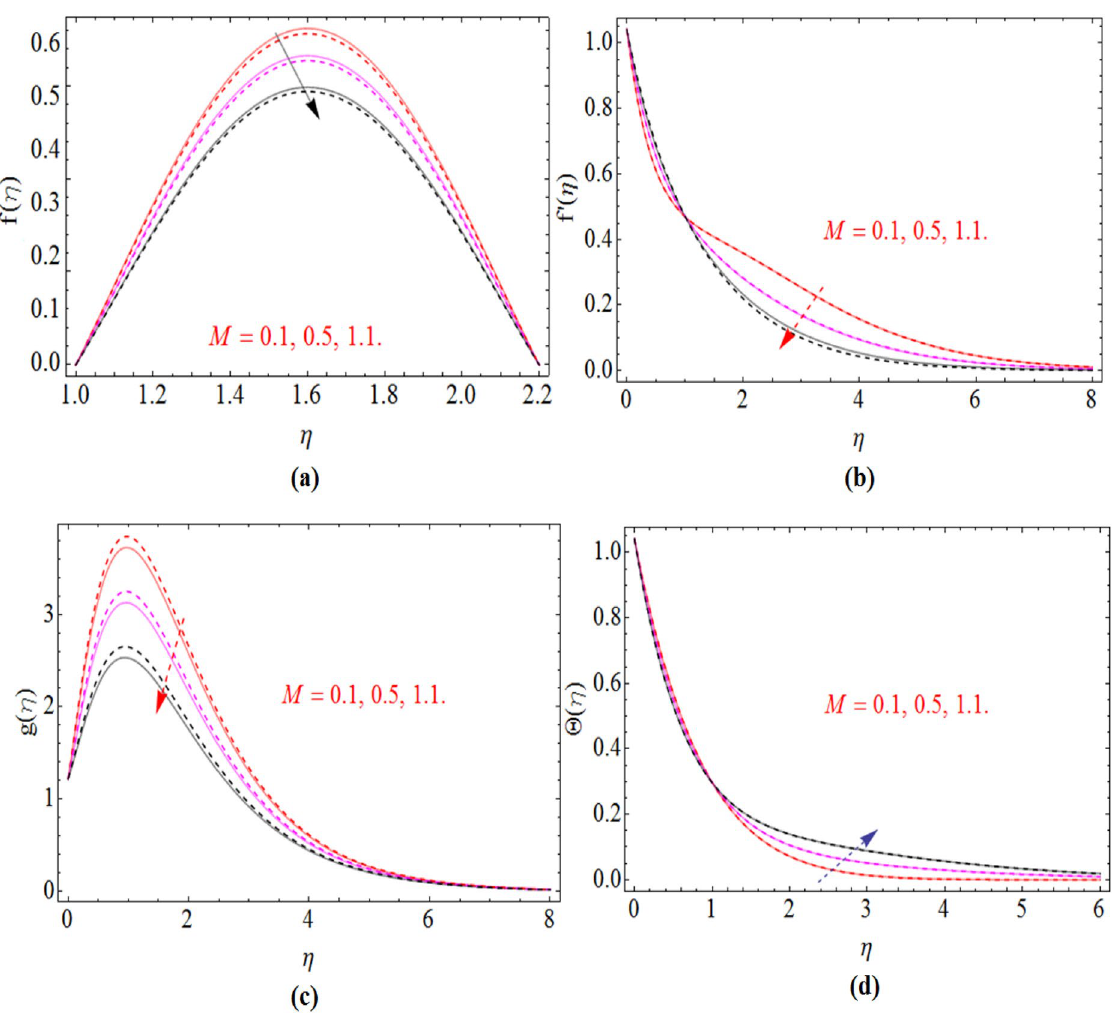
Figure 3. M impact on an axial f (η) , radial f ′ (η) and azimuthal velocity g (η) and temperature profile �(η) , for S 2 , when S 1 = 0.0. dashed lines for (cid:31) = 0.5 and lines for (cid:31) = −